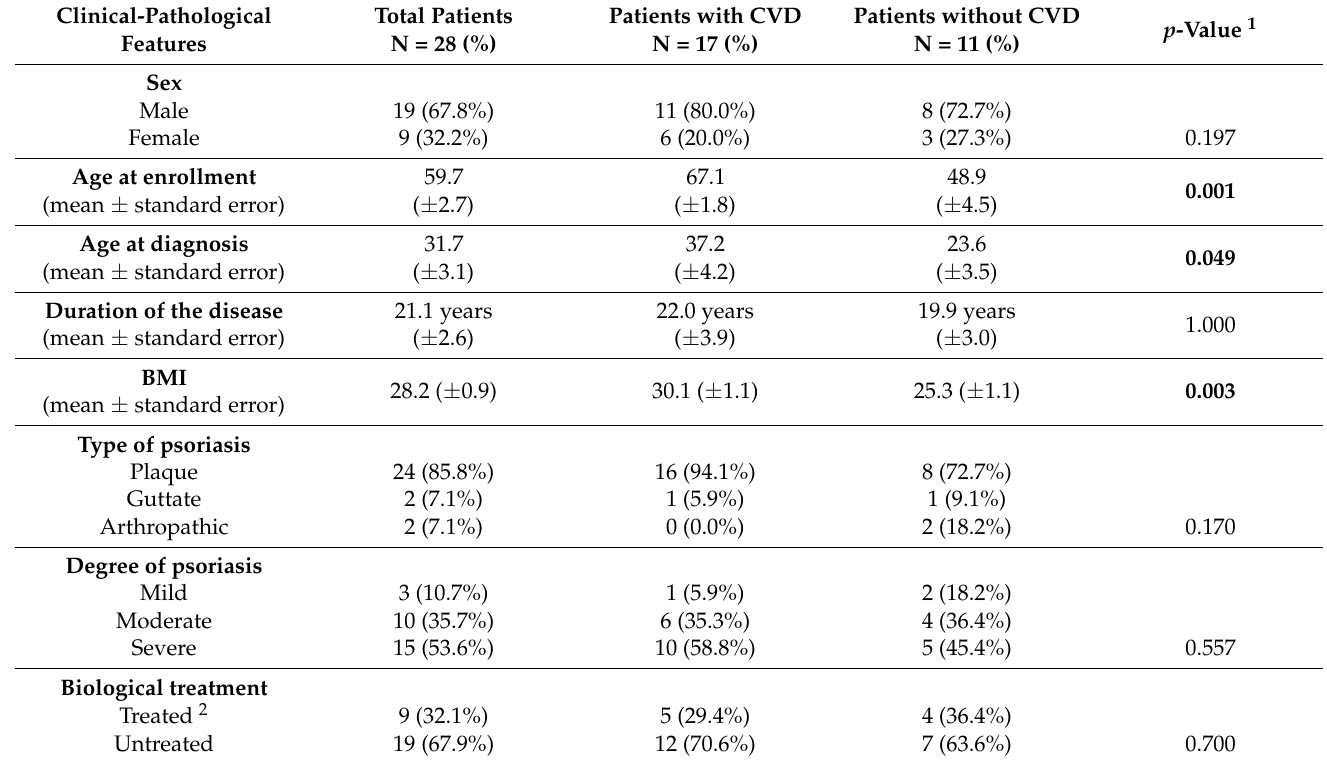
Table 1. Clinical-pathological features of the 28 psoriatic patients included in the